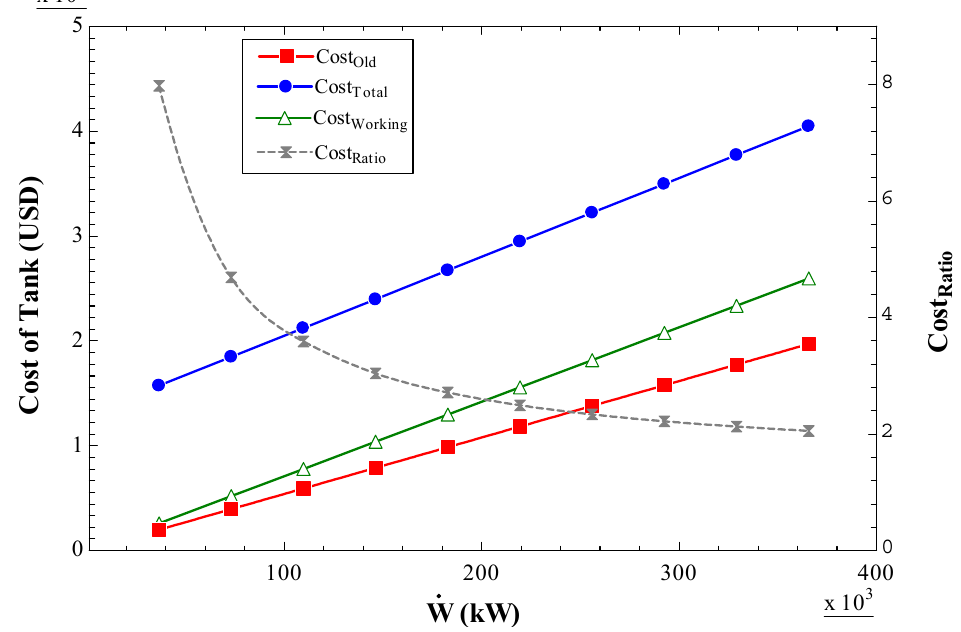
Figure 11. The cost of the cryogenic tank with total and working capacity by the old and new equation. The cost ratio shows its importance because, in the previous works, with an output power of 52 MW, a discharge time of 3 h, and a mass flowrate of 54.07 kg/s, the share of the